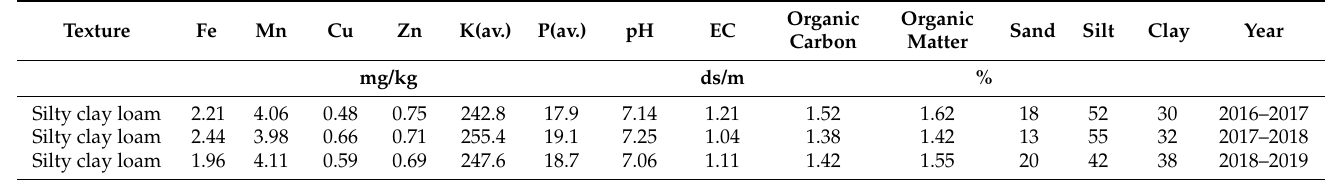
Table 4. Physical and chemical characteristics of the soil of the experiment site over three years.